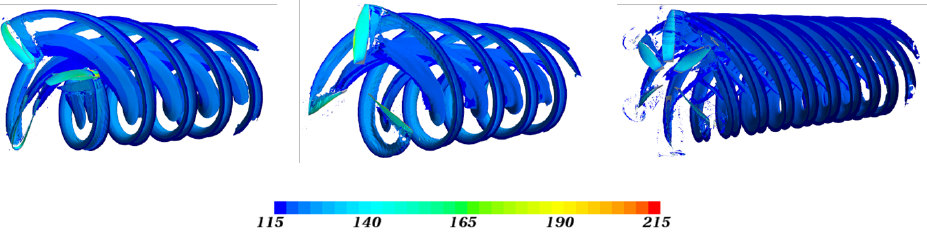
Figure 11. Iso-surfaces of the Q-criterion, colored by the velocity magnitude. From left to right: Boxprop, Conprop-3 and Conprop-6.